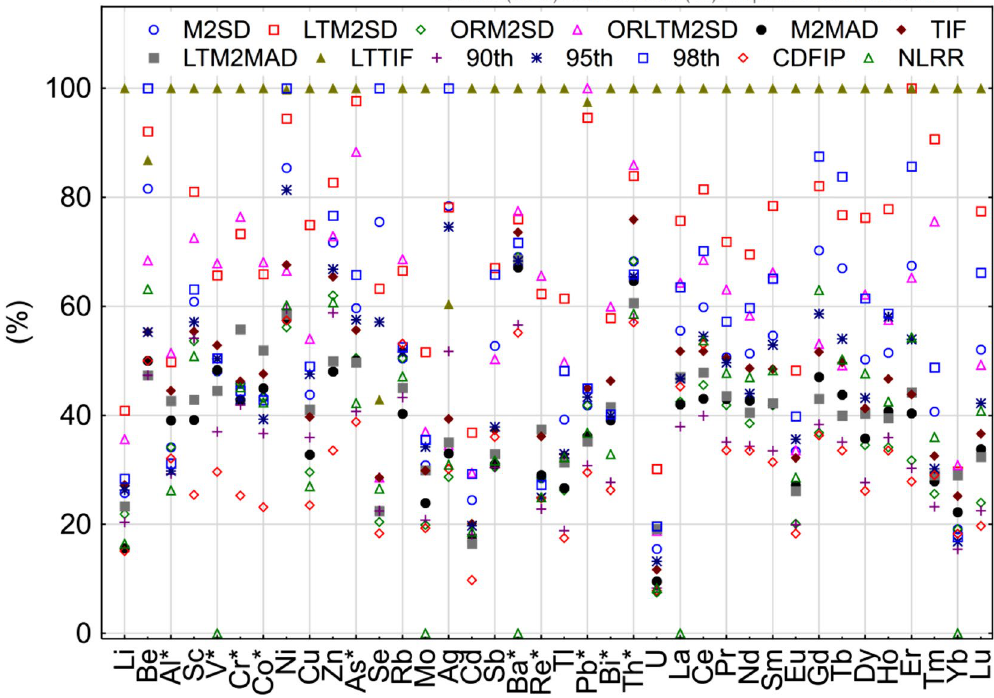
Figure 2. Variability in relative GBV values obtained by different methods (*elements having normal distribution). Figure generated in Statistica 13. (https ://softw are.dell.com/produ cts/stati stica